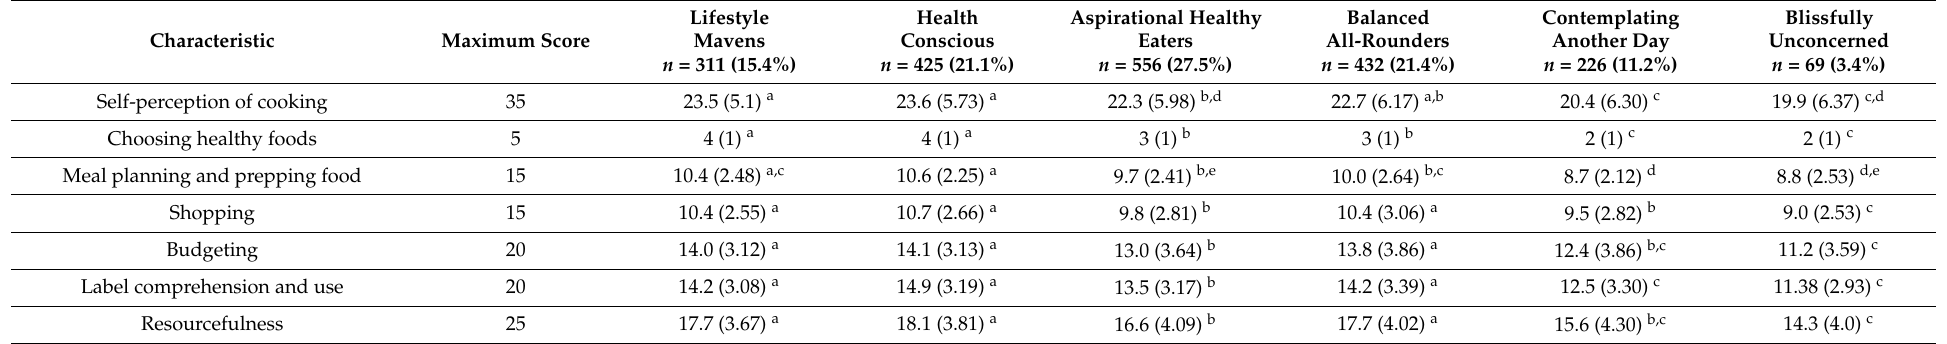
Table 3. Skills in relation to food and food preparation of Living and Eating Health Segments (LEHS) ( n =